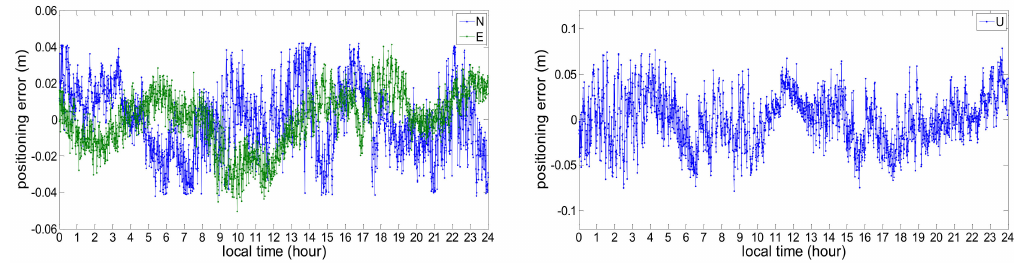
Figure 10. Positioning error of the North, East and Up direction (baseline: 260